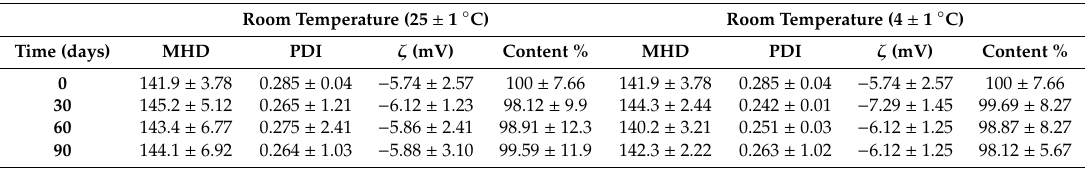
Table 3. Stability observation of MHD, PDI, ζ , and DEE % of VCM-loaded StBAclm-Qt 1 quatsomes after twelve weeks of